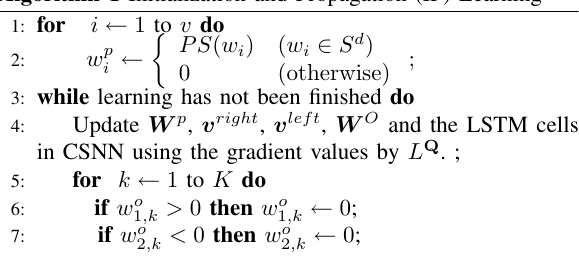
Algorithm 1 Initialization and Propagation (IP) Learning